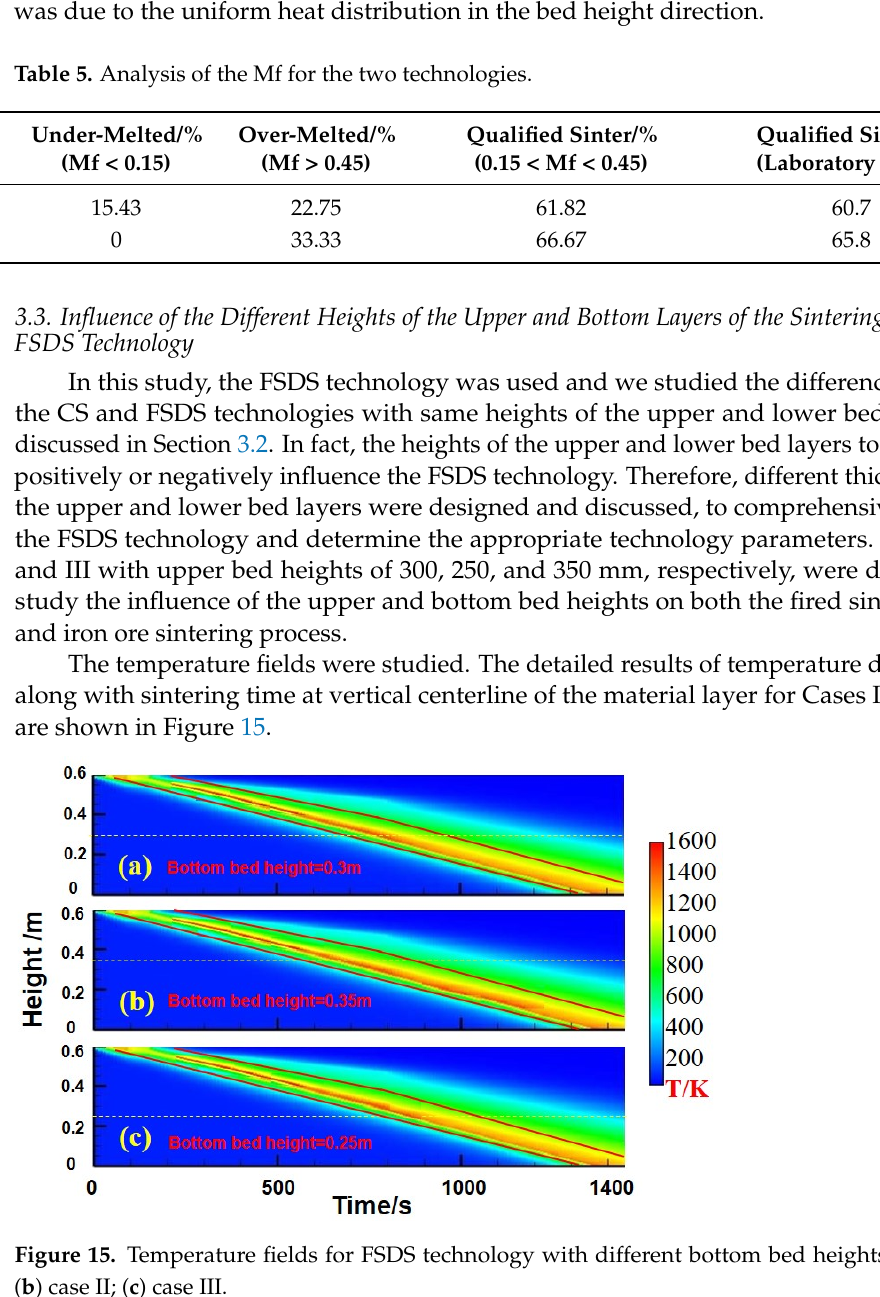
Table 5. Analysis of the Mf for the two technologies.